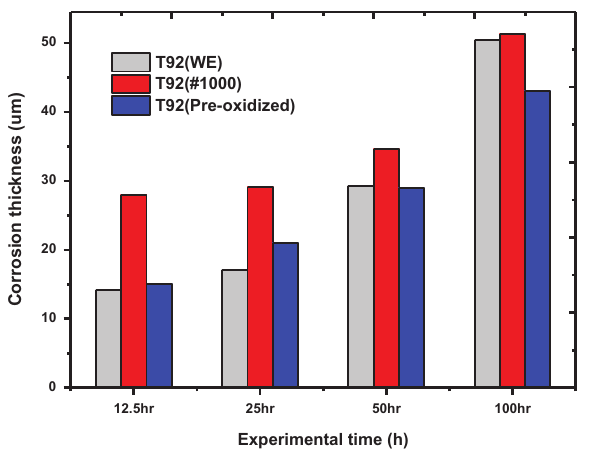
Figure 7: The thickness of oxides on the samples after different times.